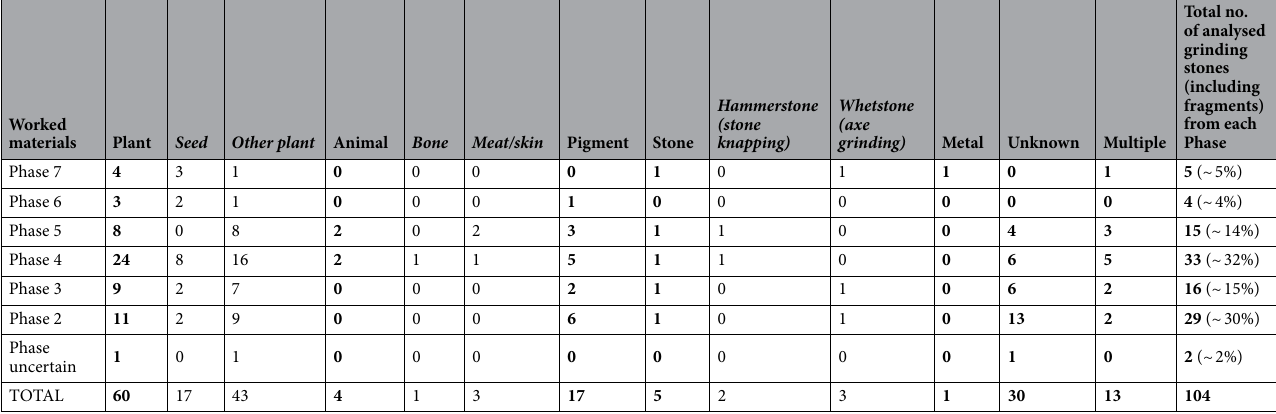
Table 2. Number and percentage of grinding stones from each phase with assigned functions and likely processed materials. Note that individual grinding stones may have multiple uses. Significant values are in